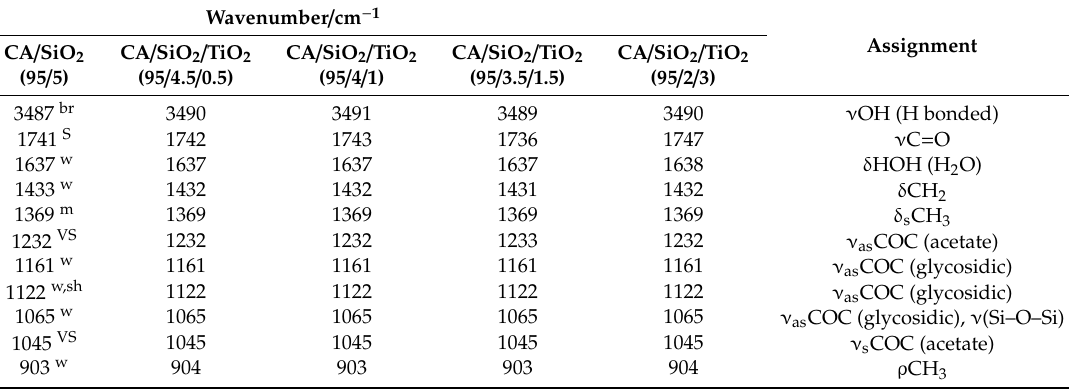
VS—very strong; S—strong; m—medium; w—weak; vw—very weak; sh—shoulder;